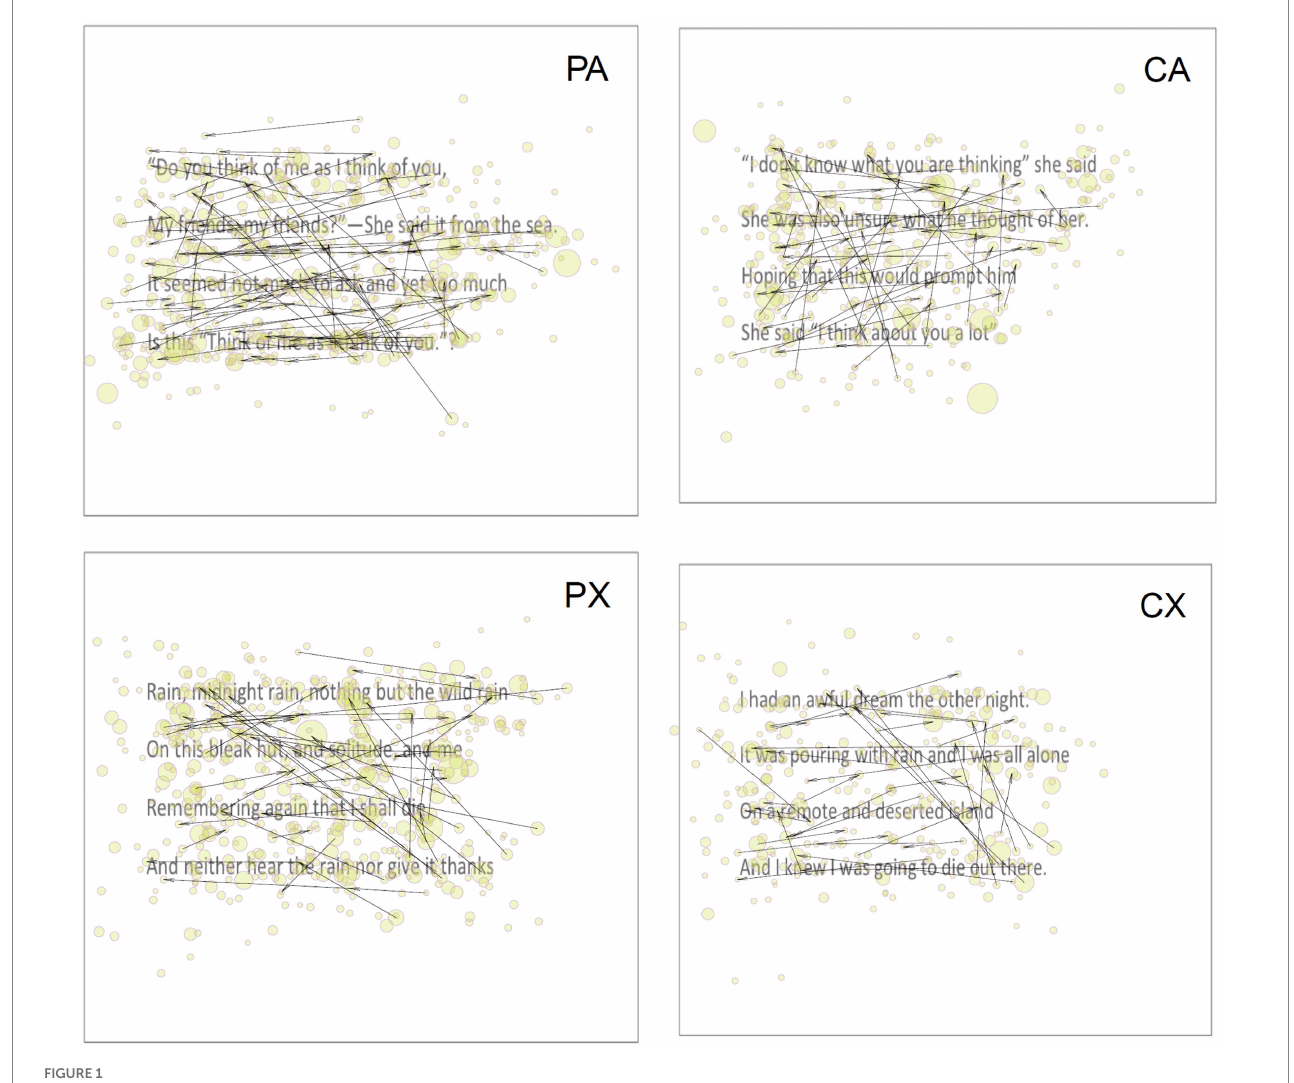
FIGURE 1 Example fixations and revisits/regressions by stimuli type. PA, poetic non-re-appraisal; CA, prosaic non-reappraisal; PX, poetic reappraisal; CX, prosaic